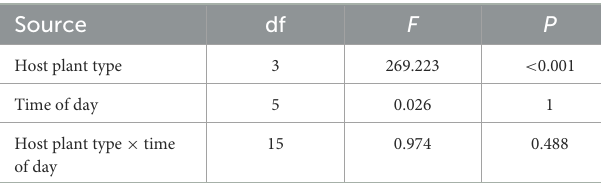
TABLE 1 ANOVA of the effects of host plant type and time of day on the feeding preference of Propylaea japonica